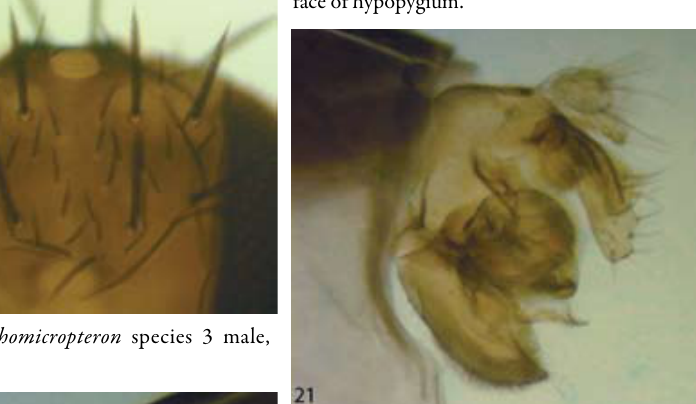
Fig. 18. Rhynchomicropteron species 3 male, left face of hypopygium. Fig. 19. Rhynchomicropteron species 3 male, right face of hypopygium.